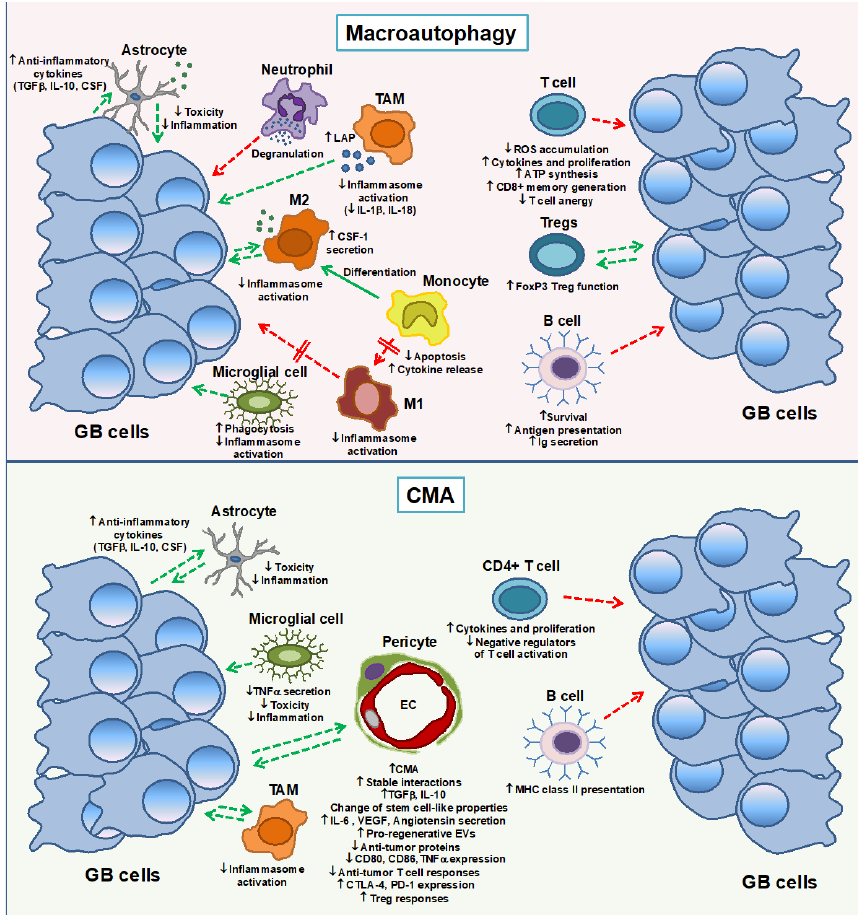
Figure 2. Autophagy function in the immune responses of peritumoral cells during GB